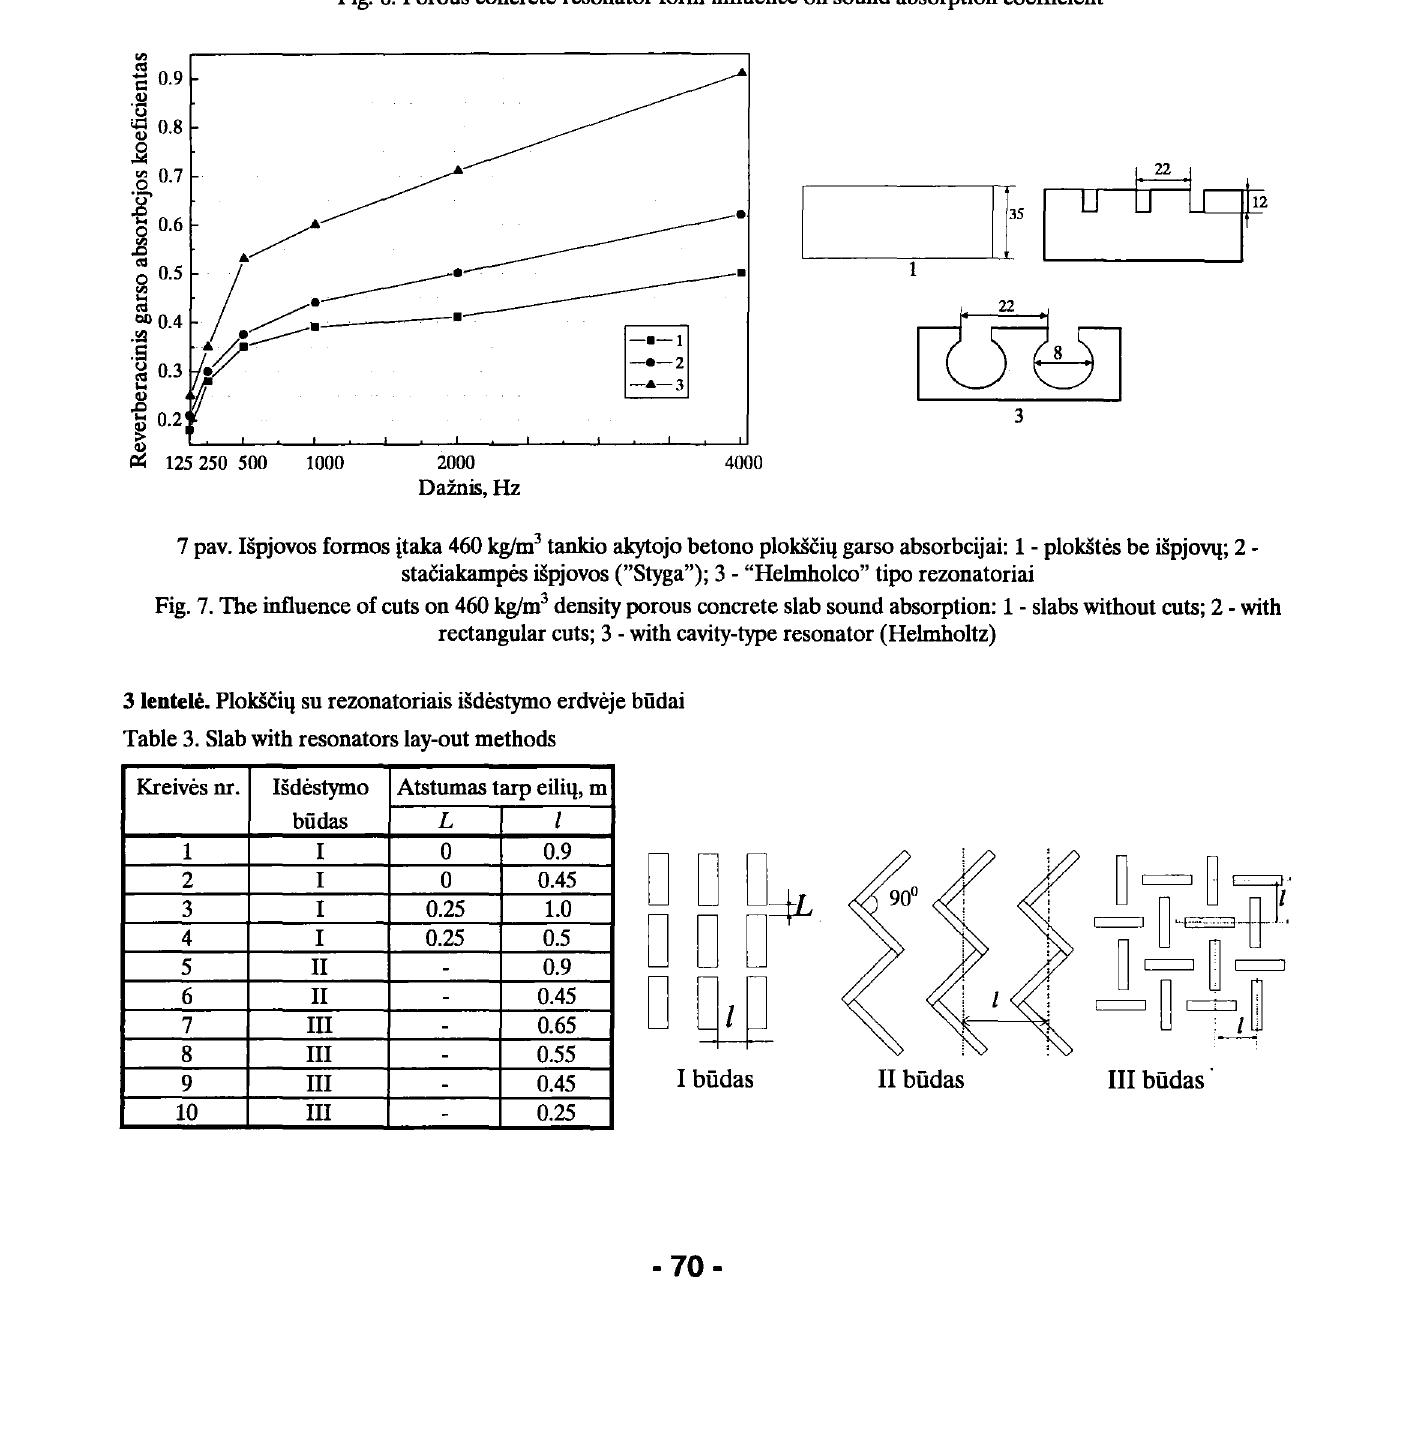
Fig. 6. Porous concrete resonator form influence on sound absorption coefficient